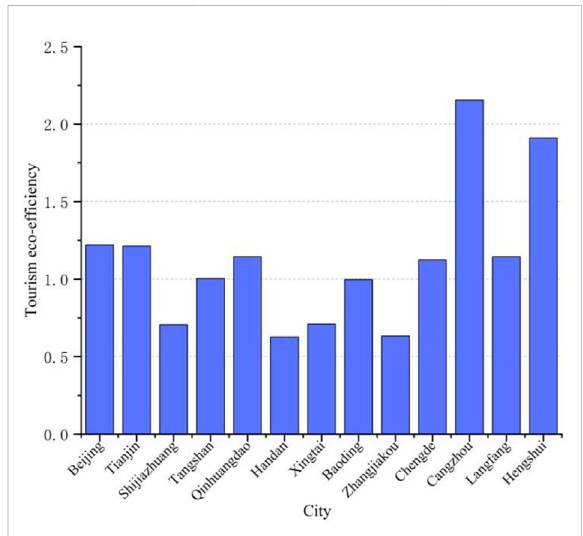
FIGURE 1 The average value of tourism eco-ef fi ciency in the Beijing- Tianjin-Hebei region from 2010 to 2019.